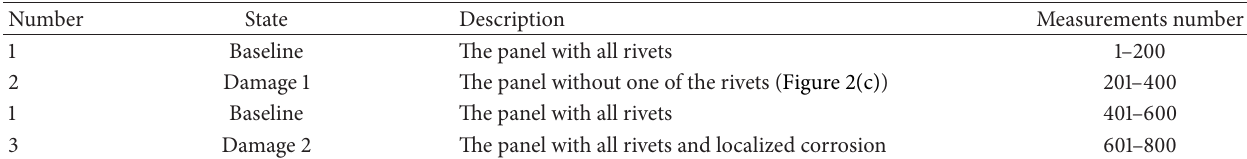
Figure 2: Aluminum aircraft panel equipped with eight PZT patches. Table 1: States of the aircraft